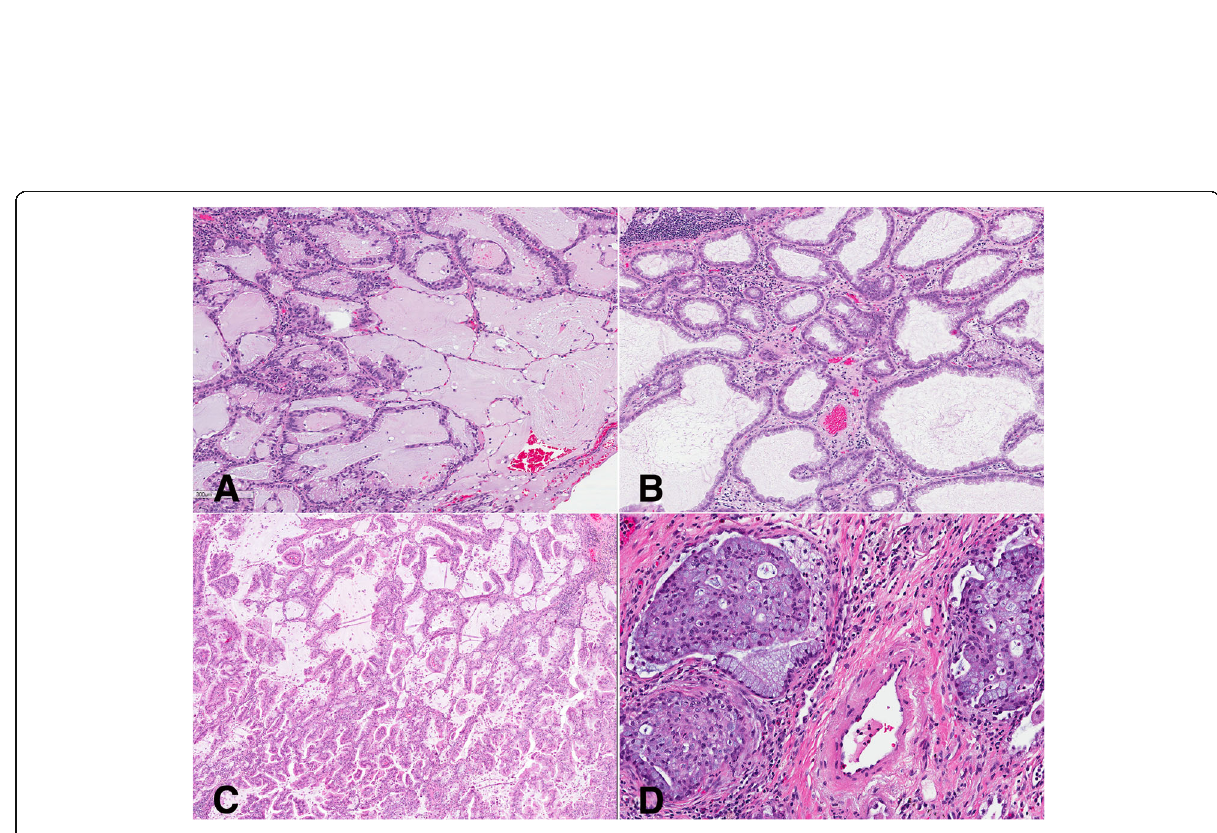
Fig. 2 Patterns of tumor growth. a , lepidic; b , acinar; c , papillary and acinar; d , focally